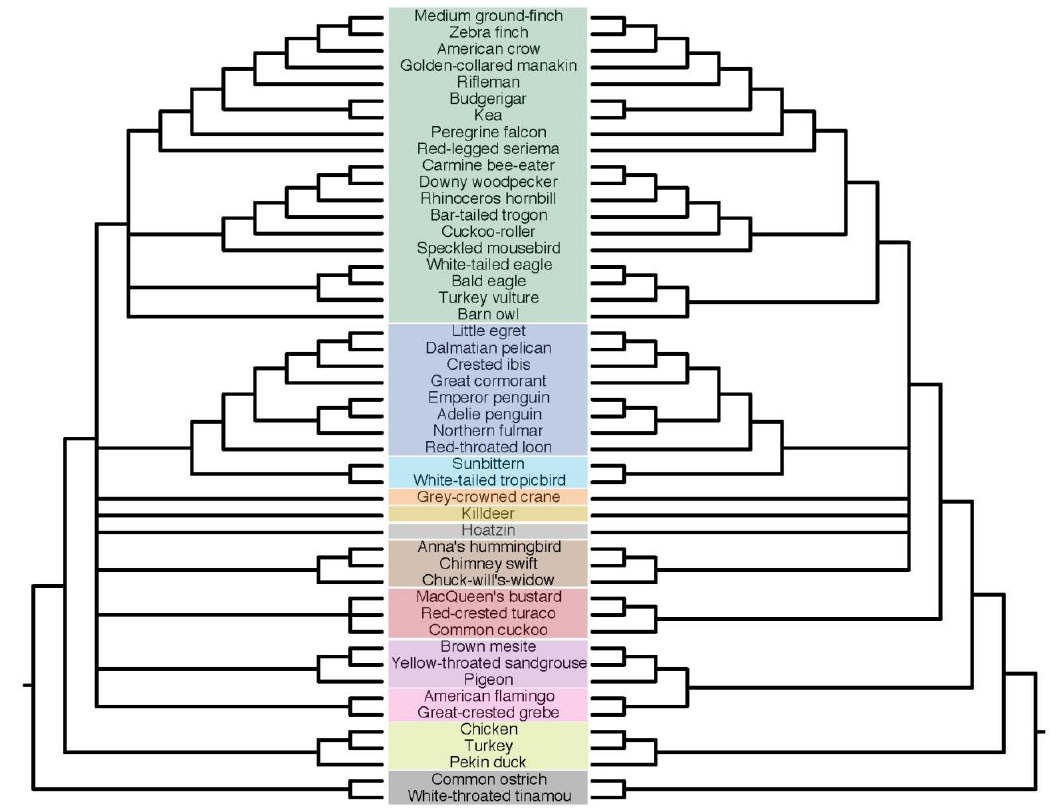
Figure 12. Collapsed polytomy trees estimated by the hard polytomy test of combined intron+UCE nt+indel implemented in ASTRAL [19] (right) compared to the polytomous tree hypothesized by Suh [17] (left). This study reduces the scale of the basal neoavian hard polytomy from a radiation of nine lineages (or even ten lineages) to a radiation of six major lineages, i.e., core landbirds (Telluraves), pan-waterbirds (Aequornithia+Phaethontimorphae), Charadriiformes, Gruiformes, Hoatzin, and Caprimulgiformes (including swift+hummingbird).